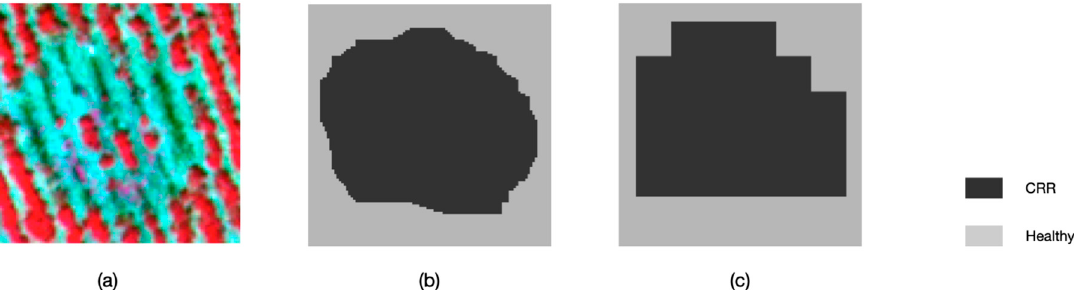
Figure 16. The pixels at the boundary of two classes could impact the accuracy. ( a ) The raw CIR image derived (Scale 1:200) ( b ) ground-truth image which could have boundary effect when compared to ( c ) real classification.